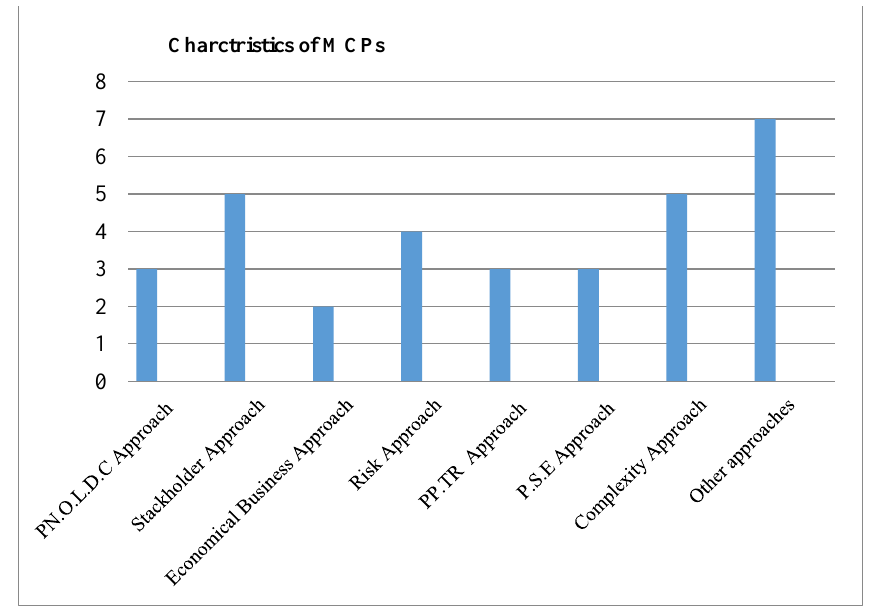
Figure 7. Degree of agreement among authors about the characteristics of MCPs depends on the previous approaches. “Source: Authors”